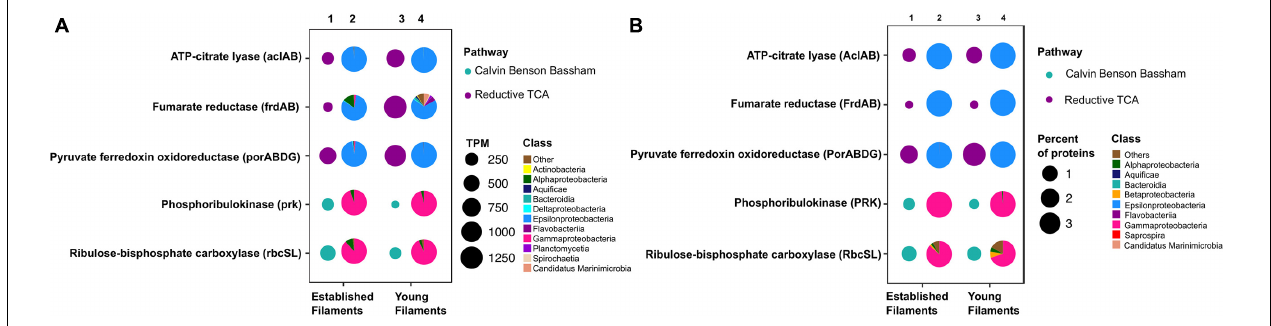
FIGURE 2 | Profiles of genes and proteins for carbon fixation in established and young filamentous biofilms. (A) Transcripts per million (TPM; columns 1 and 3) and taxonomic affiliation of reads annotated to genes (columns 2 and 4); (B) Percentage (columns 1 and 3) and taxonomic affiliation of reads annotated to proteins (columns 2 and